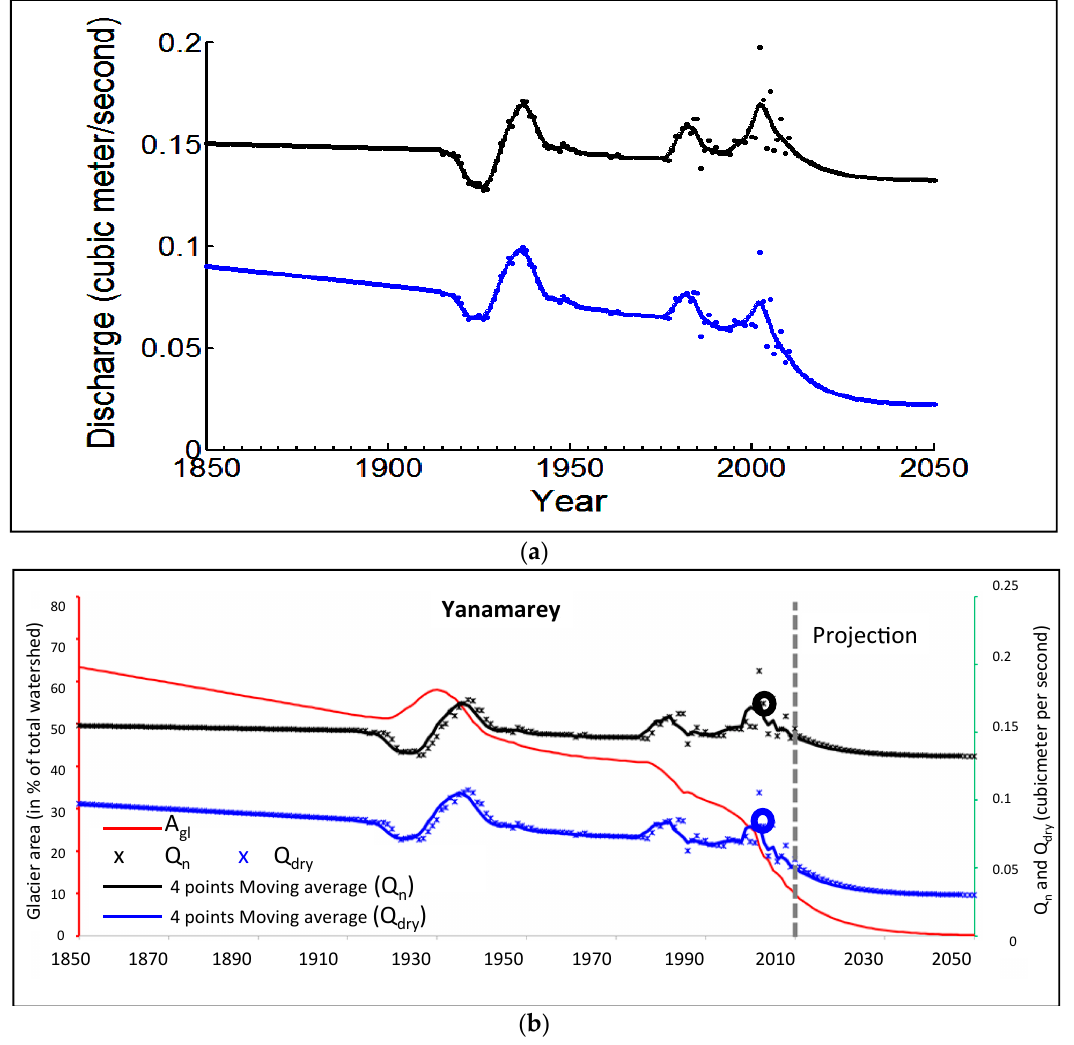
Figure 12. Modeled hydrographs for YAN. The mean yearly (black) and mean dry season (blue) discharge from the hydro balance model with change in surface area (size) of glacier (red) from the interpolation for the model input. ( a ) Three discharge peaks can be observed in both yearly and dry season discharge. Dots represent yearly individual results and the line is a smoothed curve using a smoothing spline parameter of 0.214. ( b ) Two large empty circles (black and blue) of measured discharge data (2002–2008 AD) show that the modeled data are close to the measured discharge data.